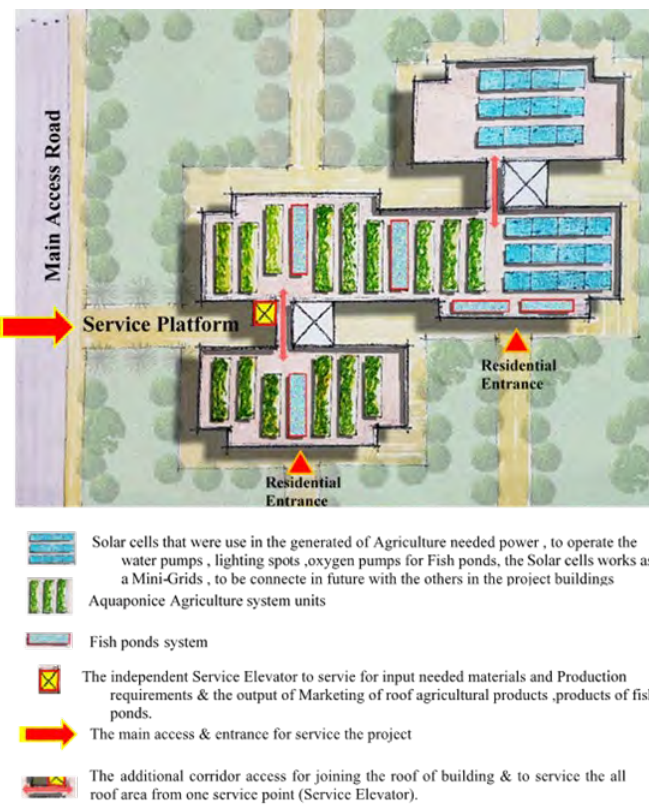
Figure 22. Proposal concept for roof agriculture typical